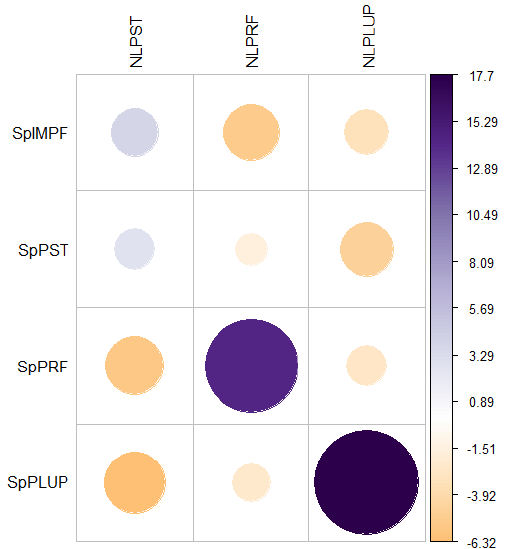
Figure 4. Visualization of Pearson residuals of Spanish tenses translated to Dutch tenses in dialogue.